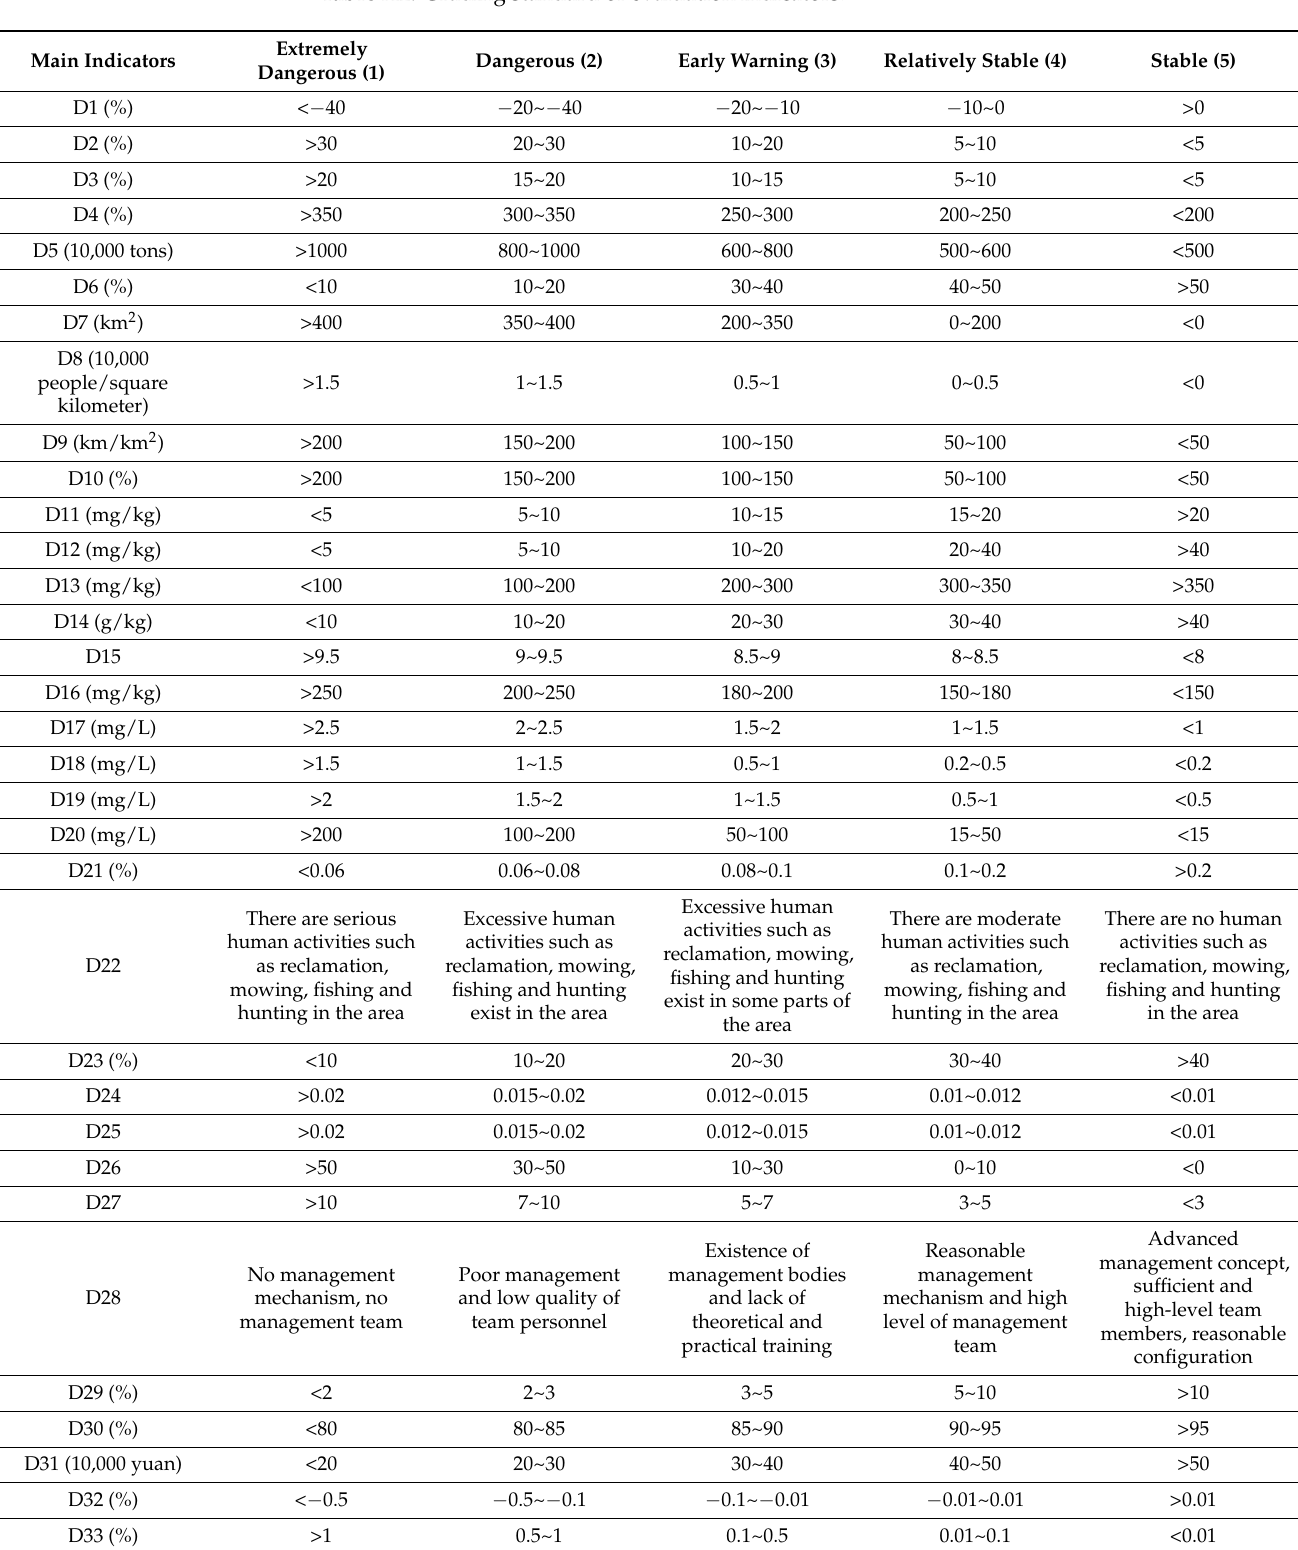
Table A2. Grading standard of evaluation